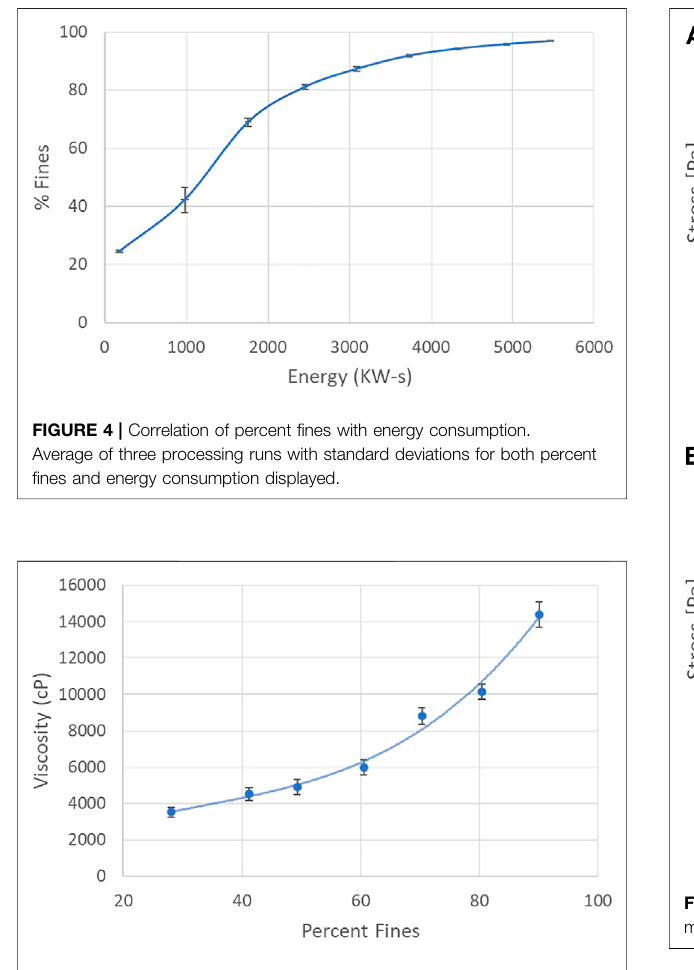
FIGURE 5 | Viscosity Characteristics of CNF Production by Percent Fines. Viscosityofre fi nedcellulosenano fi berslurries, at ∼ 2%solidsbyweight, over a range of percent fi nes.